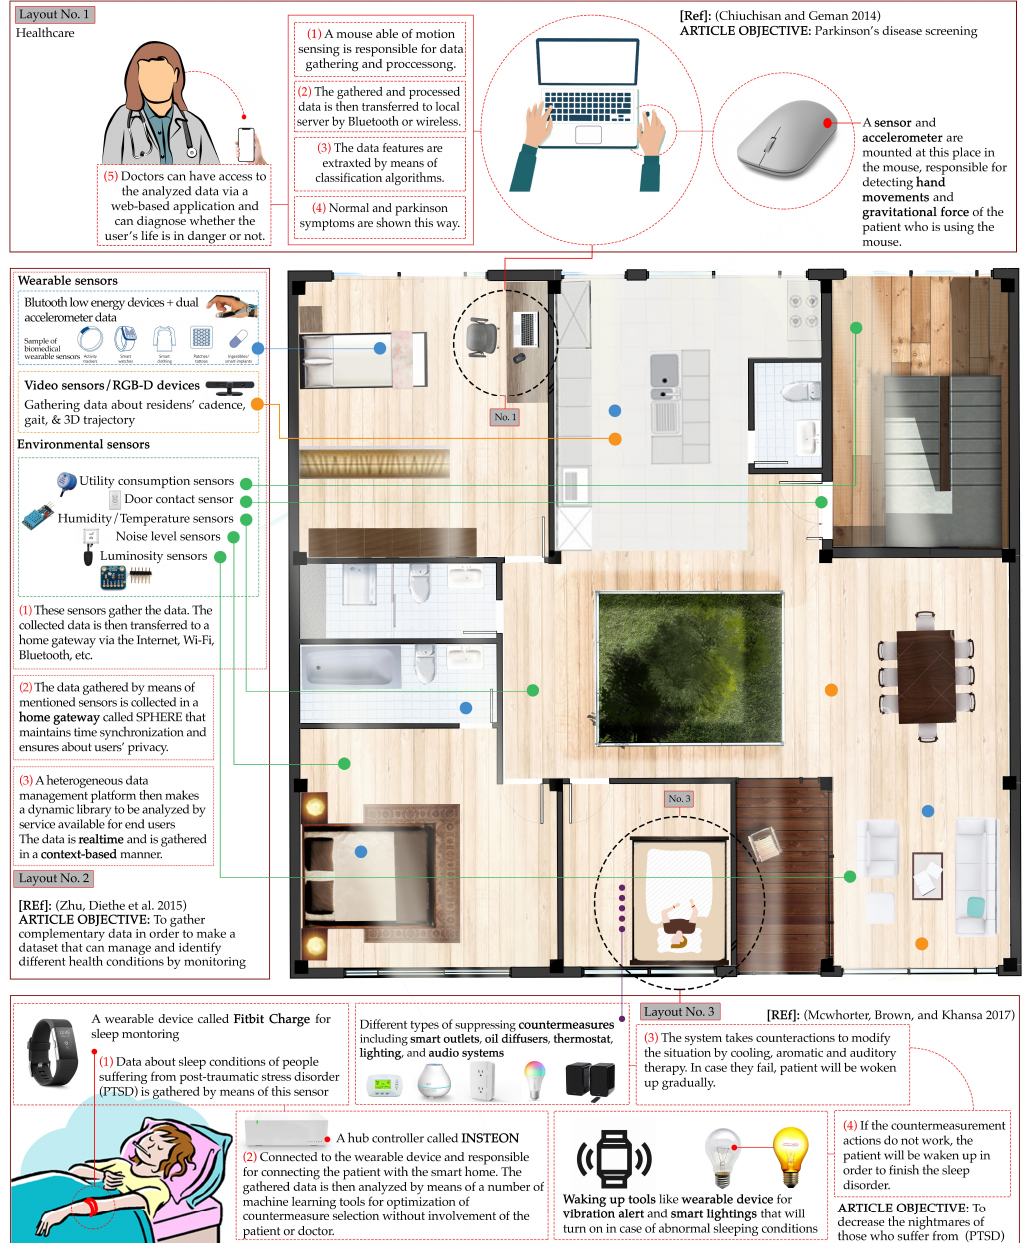
Figure 13. A typical plan of a smart home, including three smart systems, for enhancing the living environment: (i) a system for Parkinson’s disease screening [55] that is visualized in layout number 1 by authors, (ii) a system for gathering complementary data to make a dataset that can manage di ff erent health conditions by monitoring [54] that is visualized in layout number 2 by authors, and (iii) a system that can decrease the nightmares of those su ff ering from PTSD [51] that is visualized in layout number 3 by authors. Note: The location of sensors is schematically shown in the figure and can be relocated. PTSD, post-traumatic stress